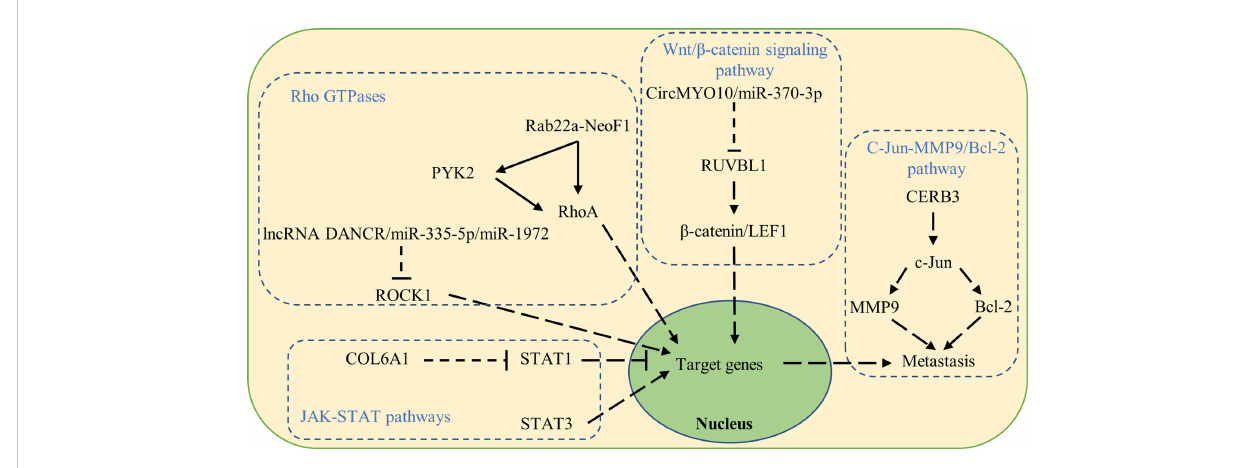
FIGURE 2 Signaling pathways that contribute to osteosarcoma metastasis when